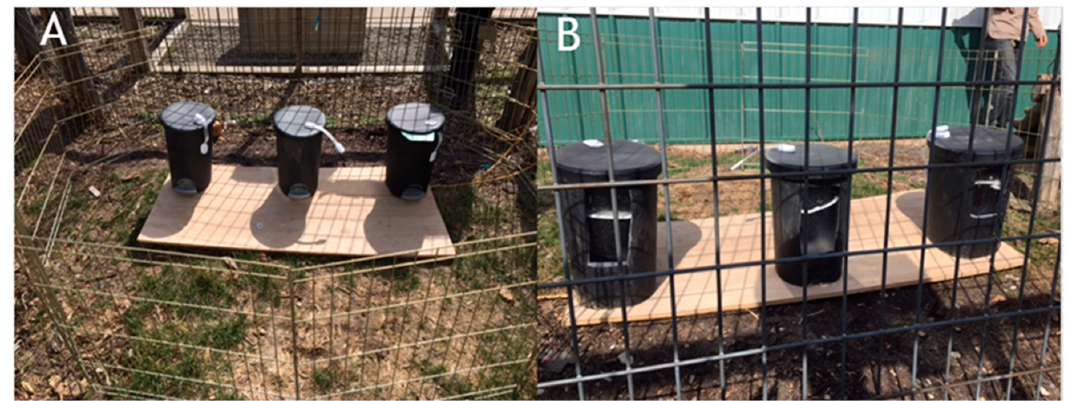
Figure 5. The apparatus and set up used for testing in Experiment 2. ( A ) Front of the apparatus. ( B ) Back of the apparatus.